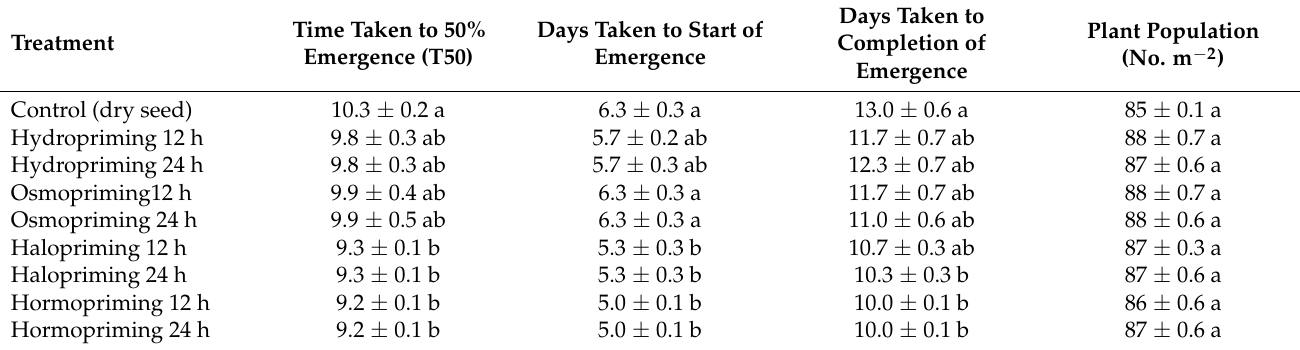
Table 2. Time taken to 50% emergence (T50), days taken to start and completion of emergence, and final plant population as affected by different seed priming in conventional direct-seeded rice (DSR) establishment method during 2018 at Ludhiana,